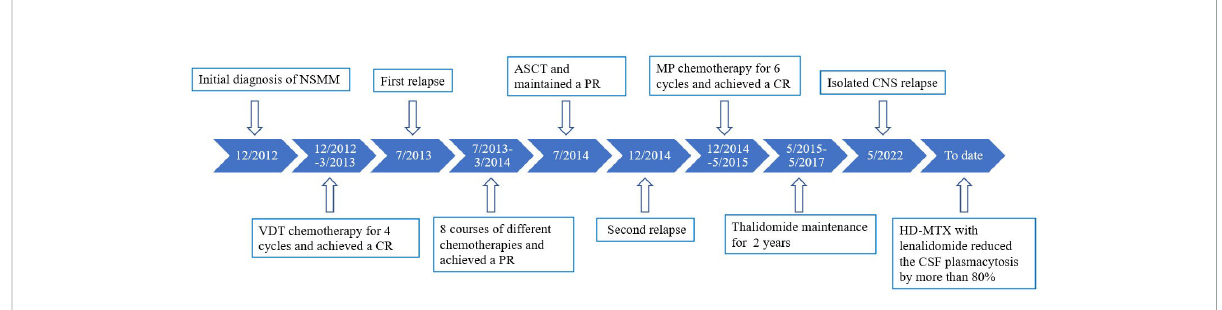
FIGURE 3 Timeline of the patient ’ s diagnosis and treatments.